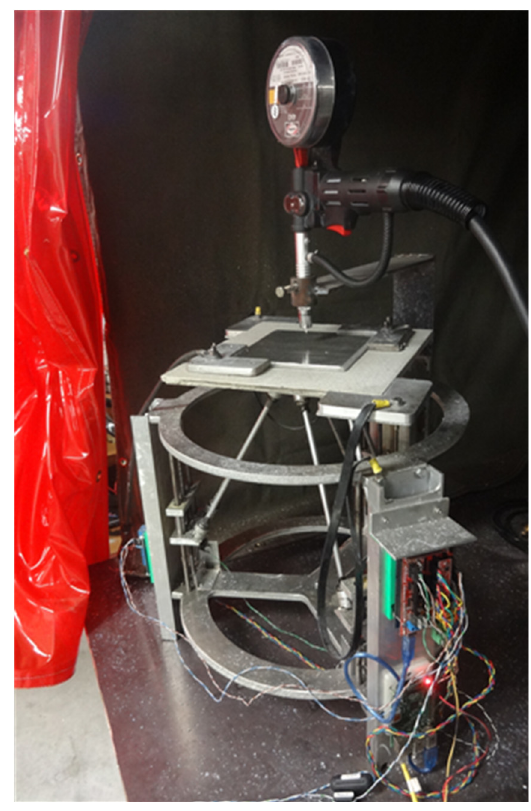
Figure 1. Photograph of magnetic ball joint metal RepRap 3-D printer used in this study. A Miller Spoolmate 100 weld gun supplied the feedstock material which was melted by a Millermatic 190 gas metal arc welders (GMAW) (not shown). In the photograph the open source Raspbery Pi and Arduino based electronics are visible on the right support column.